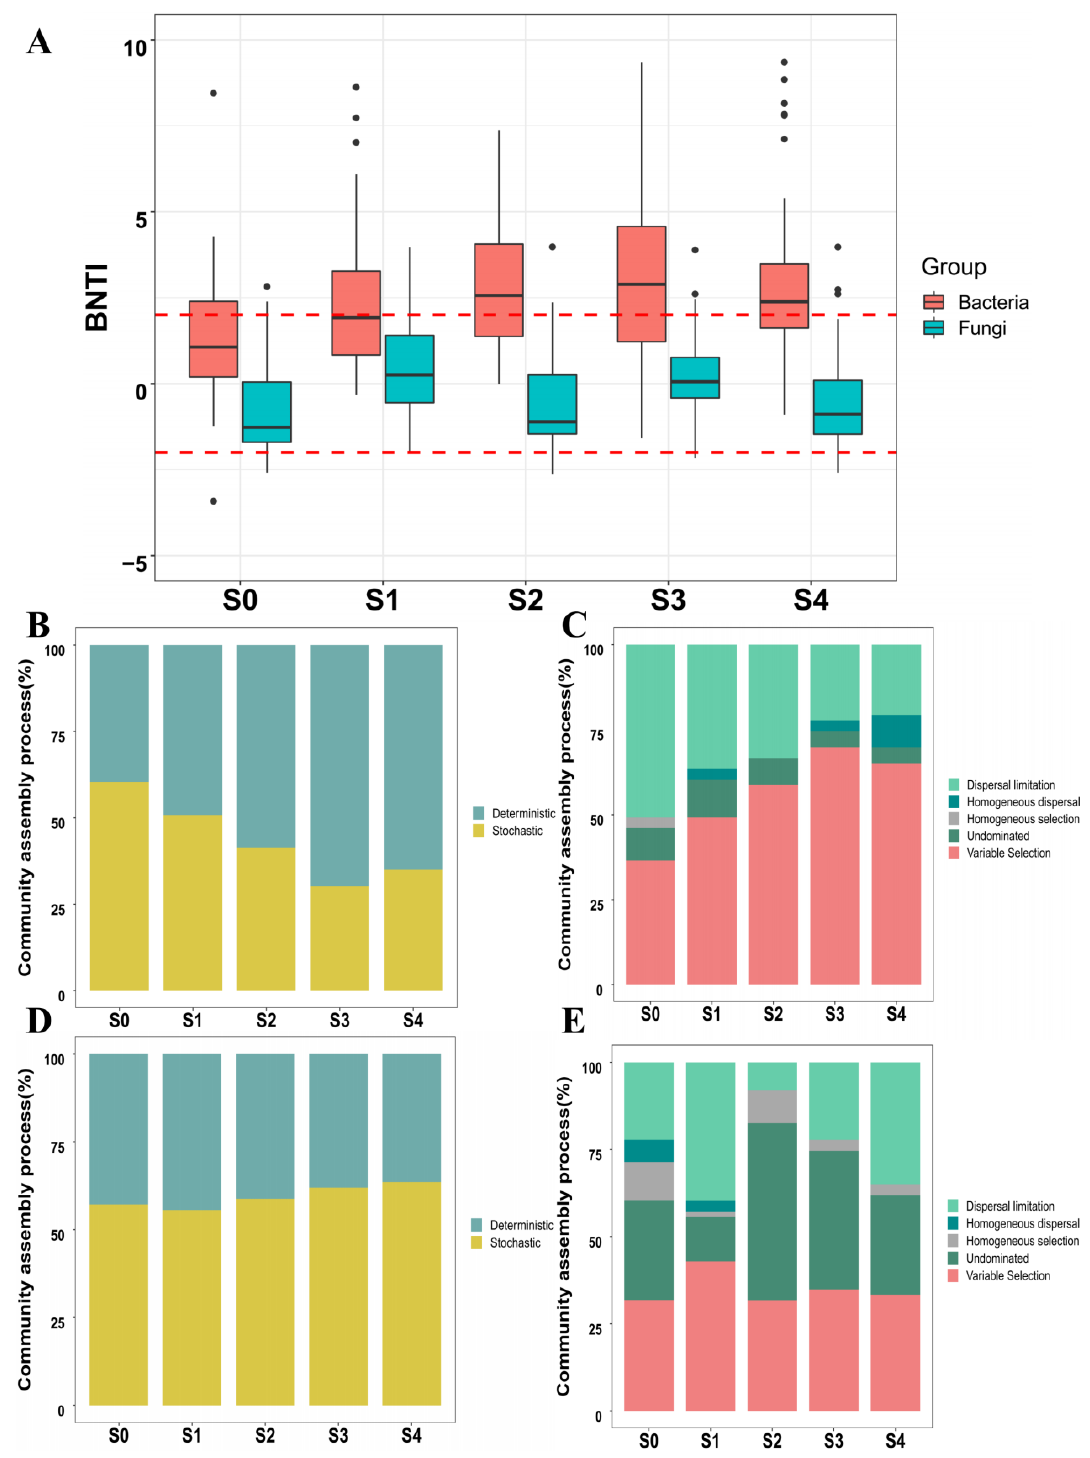
Figure 6. Microbial community assembly process associated with poplar wood discoloration. ( A ) β NTI results of the bacterial and fungal community; ( B , D ) Proportion of deterministic and stochastic processes of the bacterial and fungal community; and ( C , E ) RC bray results of the bacterial and fungal community.